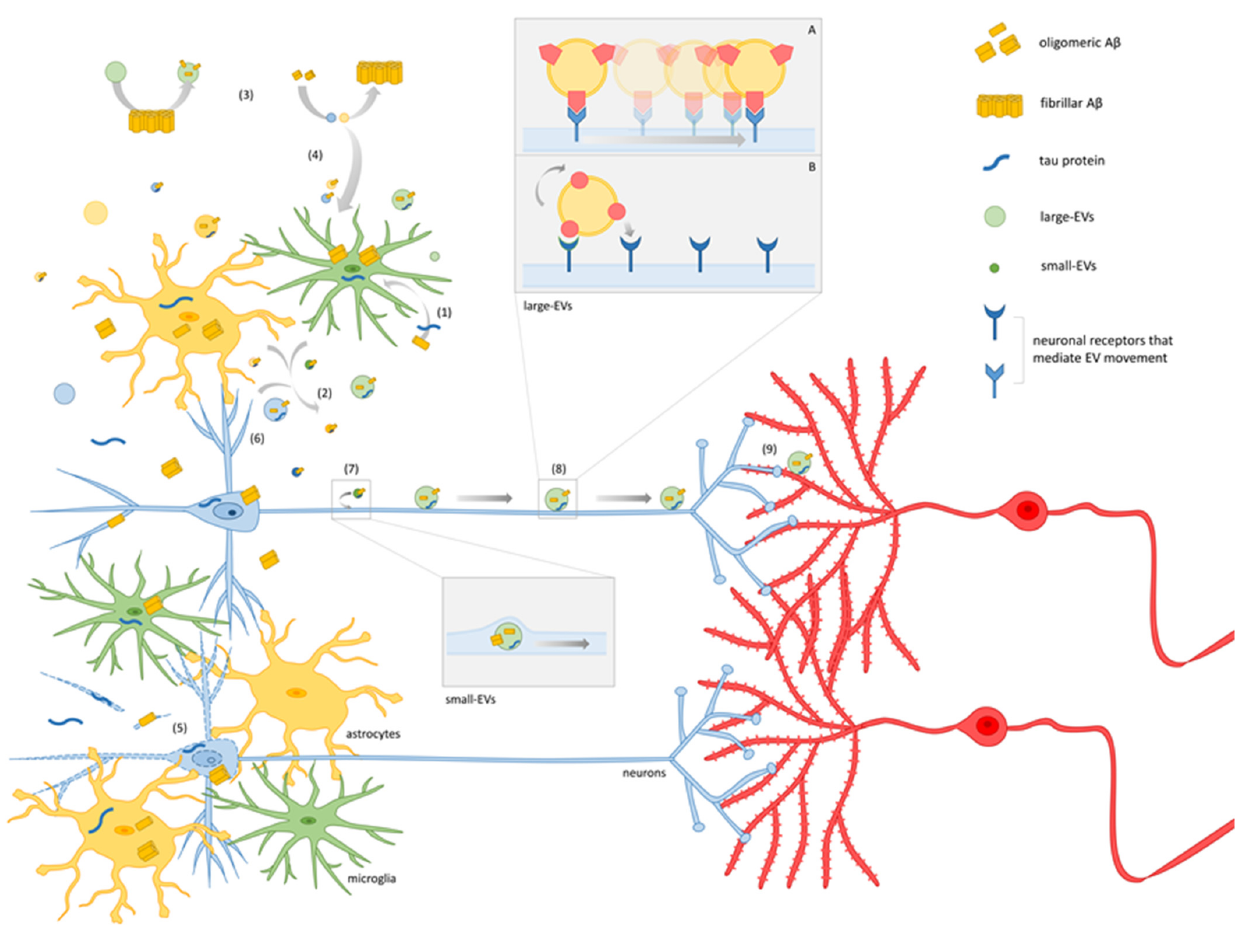
Figure 2. Mechanisms of EV-mediated propagation of synaptic dysfunction. Scheme of the onset and propagation of synaptic dysfunction in vulnerable brain regions in the early phases of AD. The model is described in the text section “A model for EV-mediated propagation of synaptic dysfunction”. Parts of the figures were drawn by using pictures from Servier Medical Art, licensed under a